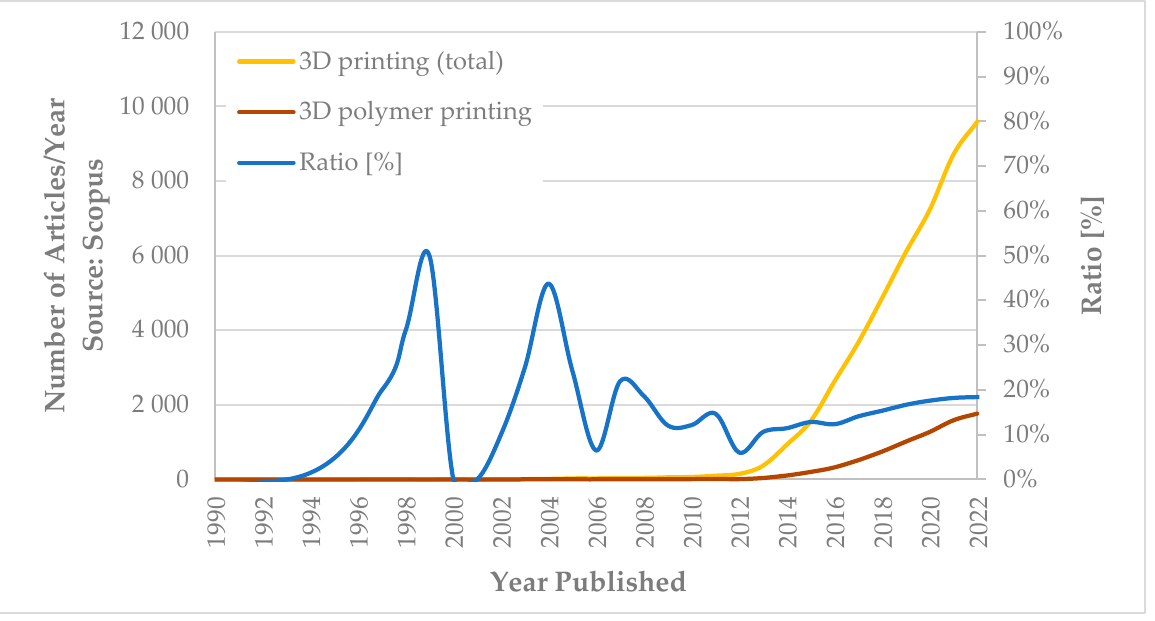
Figure 1. Publications indexed in the Scopus database between 1990 and 2022 (own formatting based on internet database).